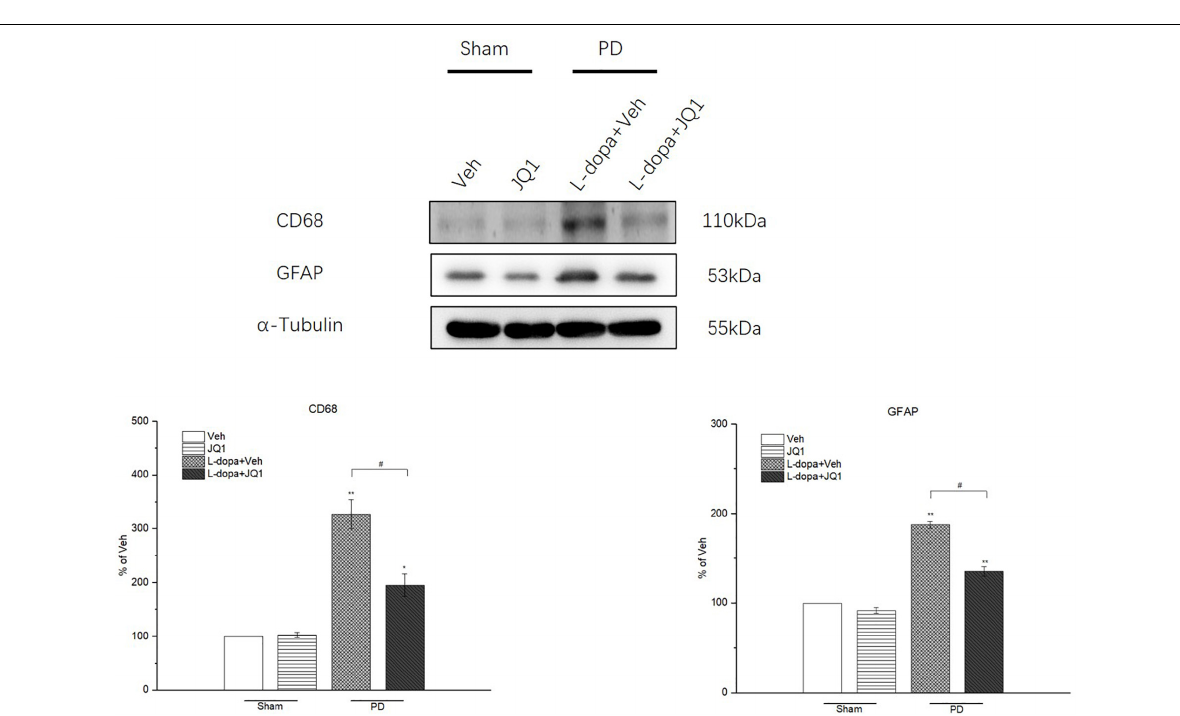
Frontiers in Neuroscience |